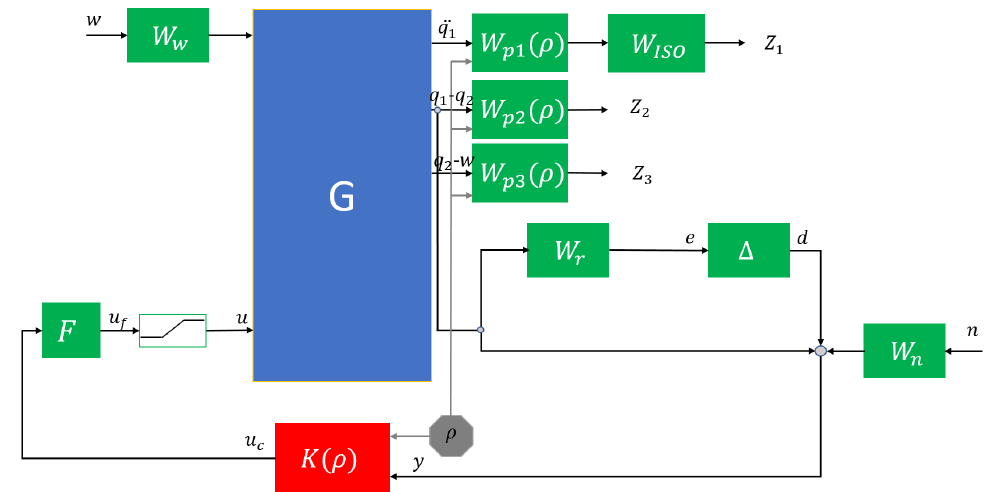
Figure 3. Closed-loop interconnection